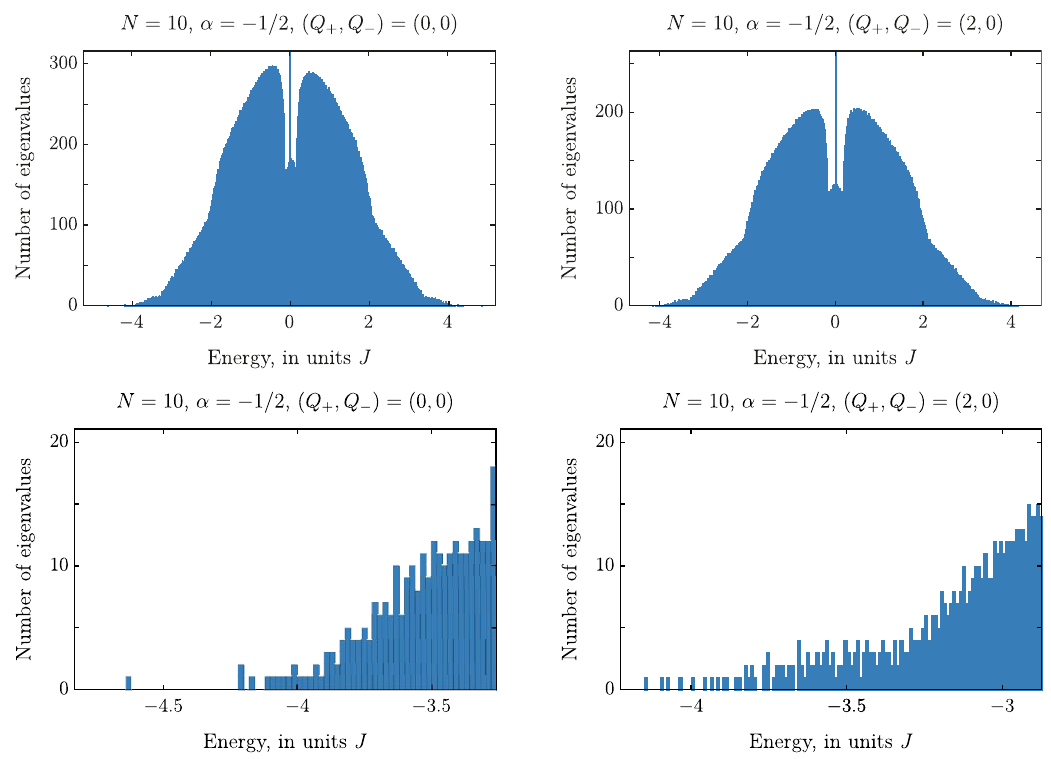
Figure 8 . Density of states in two of the charge sectors, ( Q + , Q − ) = (0 , 0) and (2 , 0) , for a single realization of the model with N = 10 and α = − 1 / 2 . The lower plots are zoomed in regions near the ground state. We observe a prominent gap in the ( Q + , Q − ) = (0 , 0)